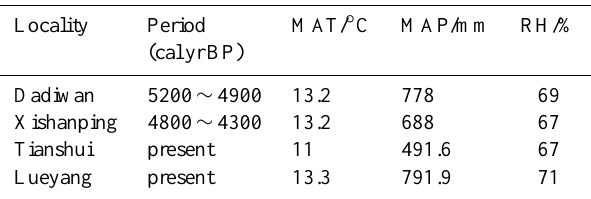
Table 5. The comparison of the climatic factors among Dadiwan, Xishanping, Tianshui and